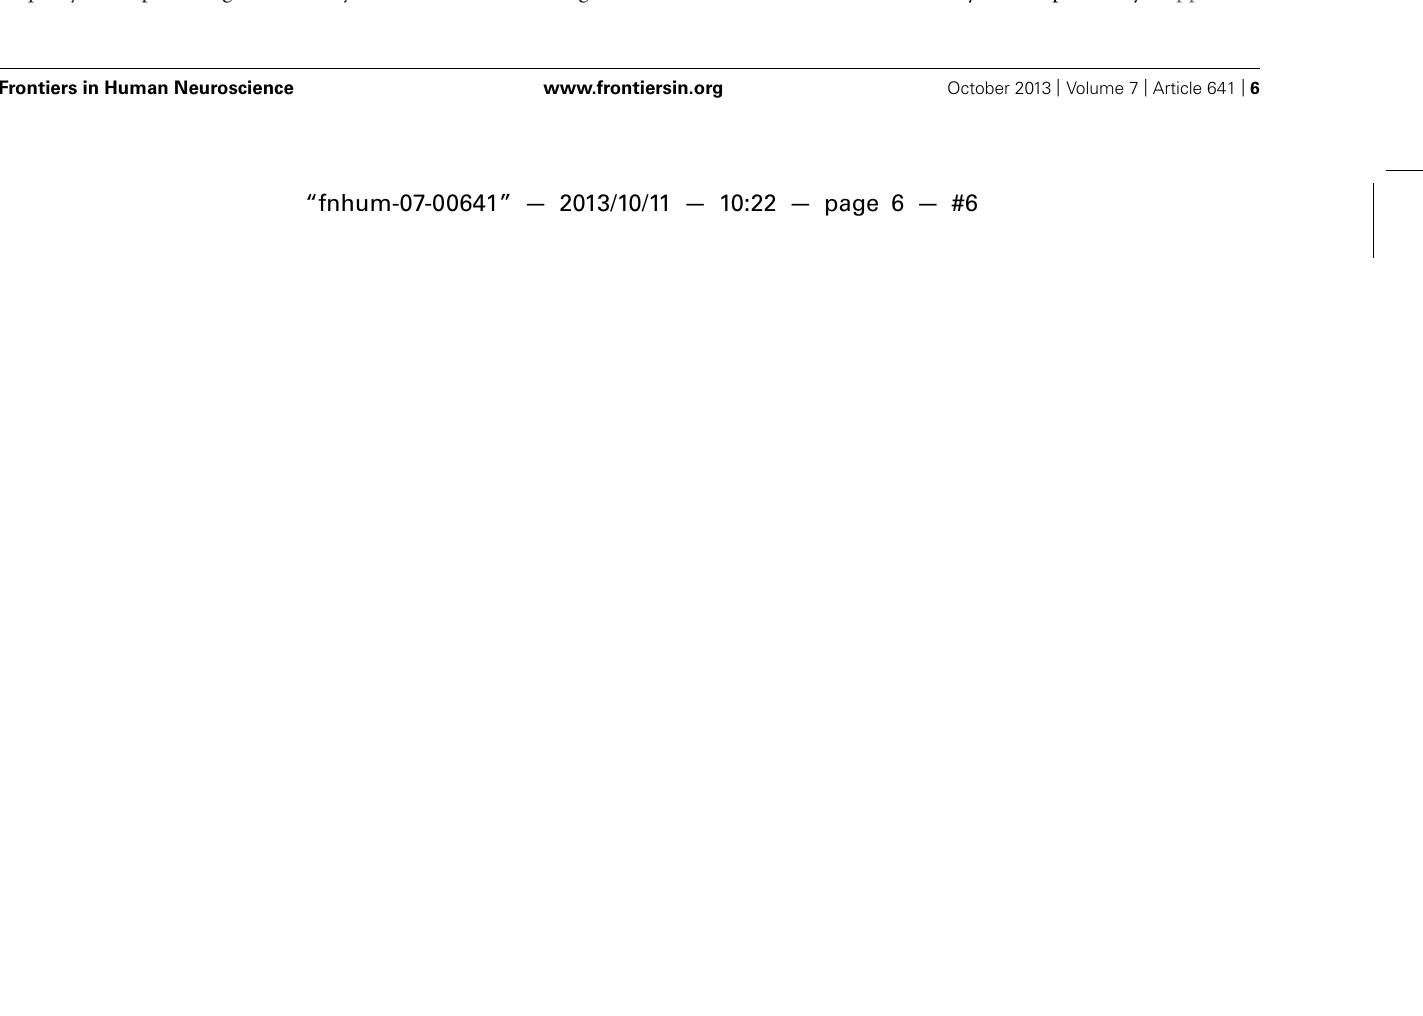
FIGURE 3 | Grand average ERP waveforms for incorrectly identified and correctly identifiedT2 images. For illustrative purposes, only the midline electrode sites Fz, Cz, and Pz are displayed.